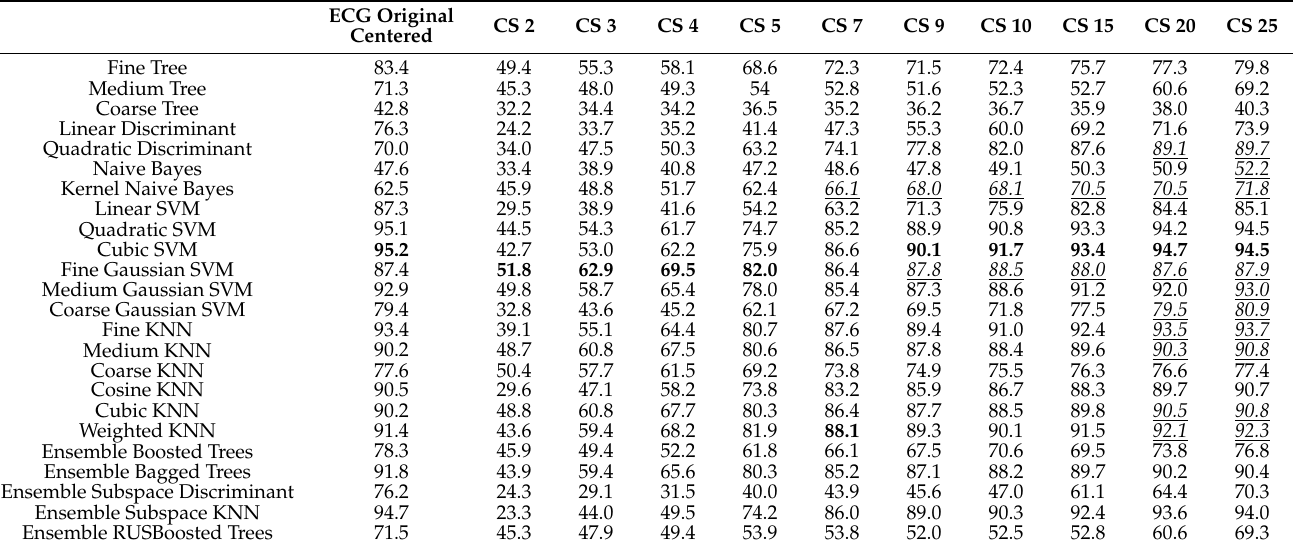
Figure 4. Classification results with CS method for dimensionality reduction. Table 2. Classification results with CS method for dimensionality